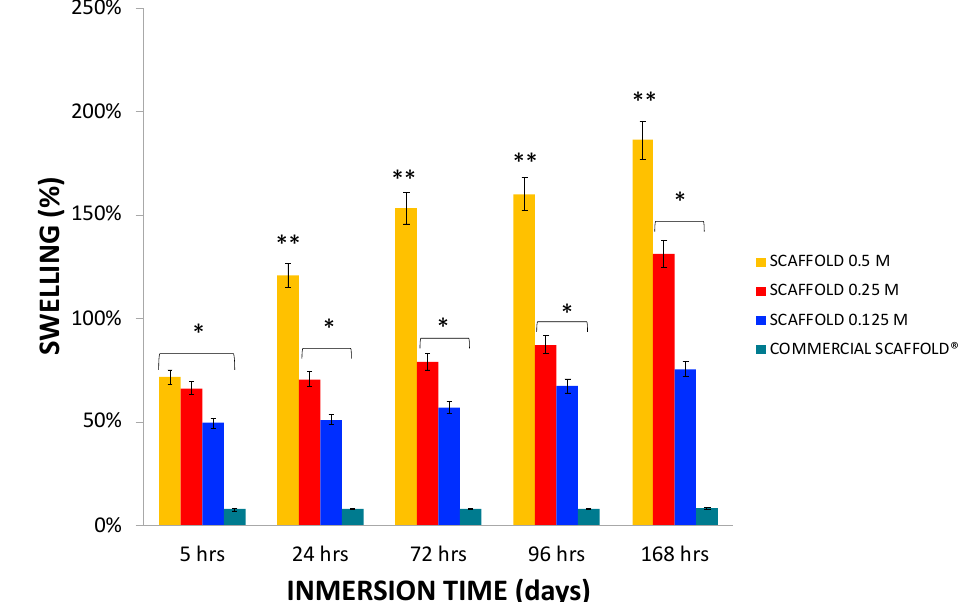
Figure 7. The swelling behavior of the scaffolds was determined gravimetrically by incubating scaffolds with PBS at 37 ◦ C (pH 7.4) at different time intervals. The swelling of the 0.125 M and 0.25 M scaffolds was greater than that of the commercial scaffolds at 5, 24, 72, 96, and 168 h * p < 0.05, while the swelling of the 0.5 M scaffolds was greater than that of the 0.125 M, 0.25 M and commercial scaffolds at 24, 72, 96, and 168 h ** p < 0.0001. Mean ± SD n > 3.